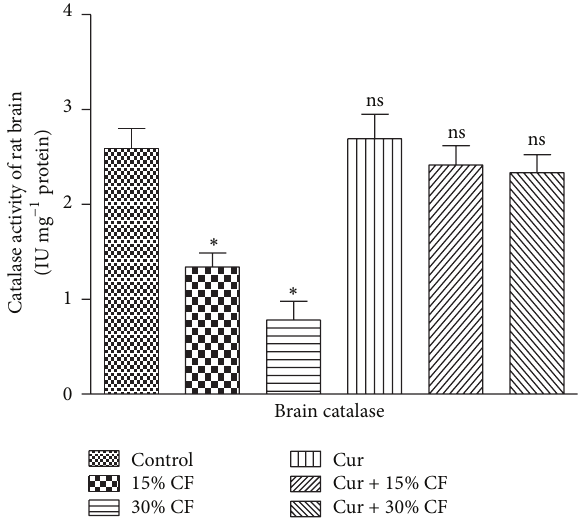
Figure 3: Effects of carbofuran and curcumin on the activity of GST in the brain stem of rat. The procedures for the administration of carbofuran and pretreatment with curcumin as well as assay of GST activity were the same as mentioned in Section 2. The unit of enzyme activity was expressed as 𝜇 molemL −1 min −1 mg −1 protein. The data represent mean ± SD of 5 independent experiments. ∗ and ∗∗ indicate the 𝑃 values significant at < 0.001 and < 0.05, respectively, and ns refers to nonsignificant at 𝑃 > 0.05 as compared to control